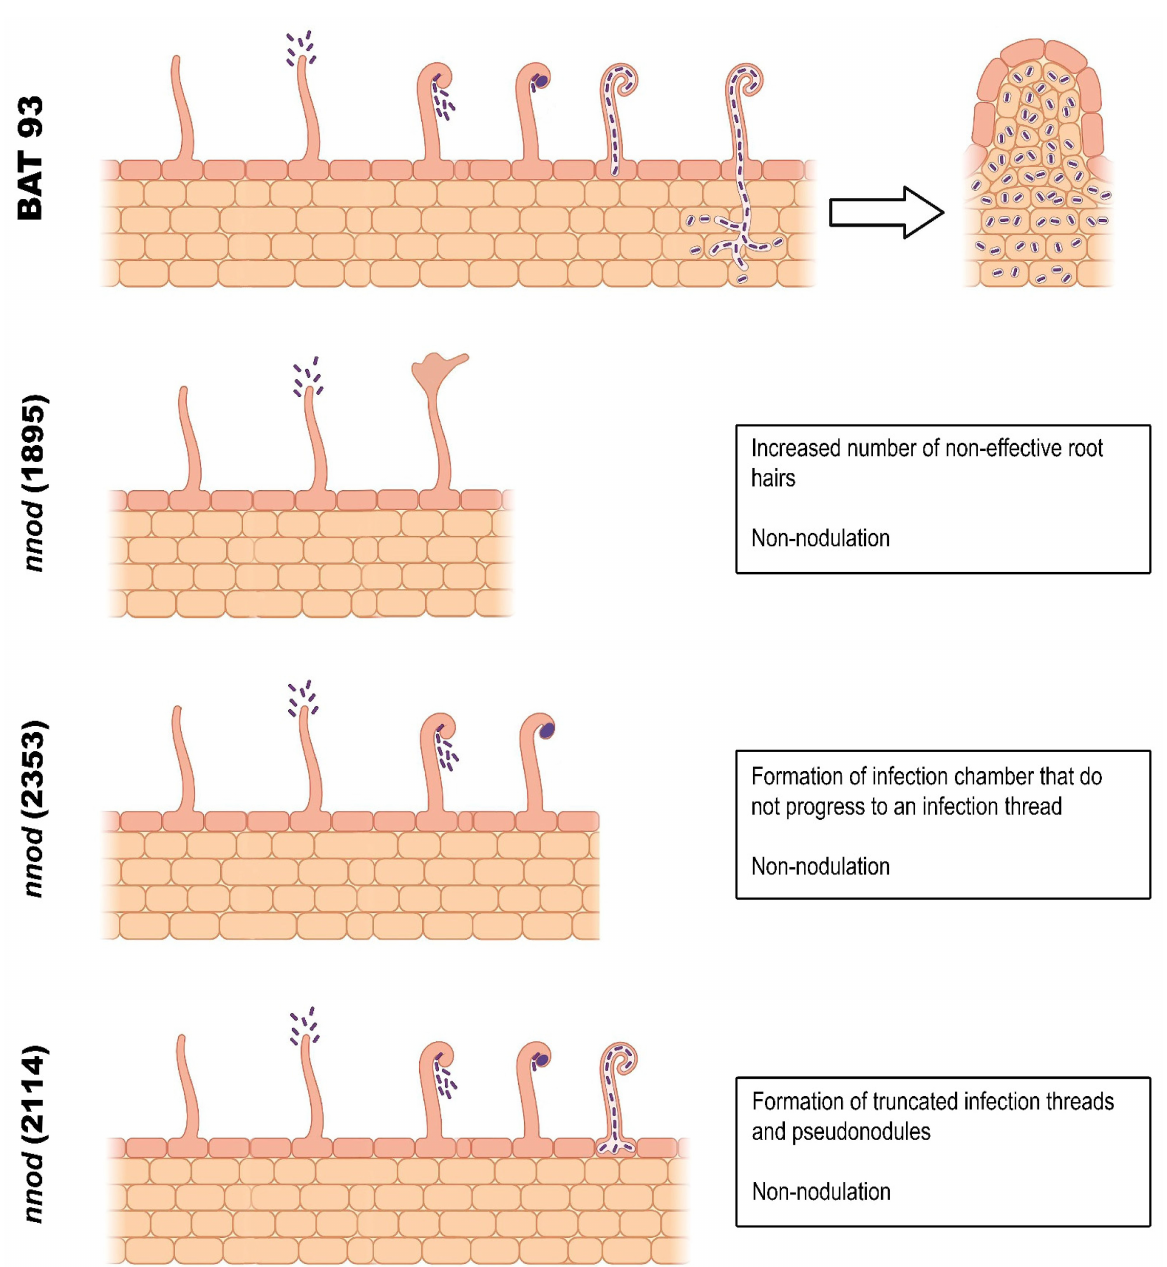
Figure 7. Summary of the defective phenotype of P. vulgaris non-nodulating mutants: nnod (1985), nnod (2353) and nnod (2114), impaired in a different step of the rhizobia infection process. This figure was created with